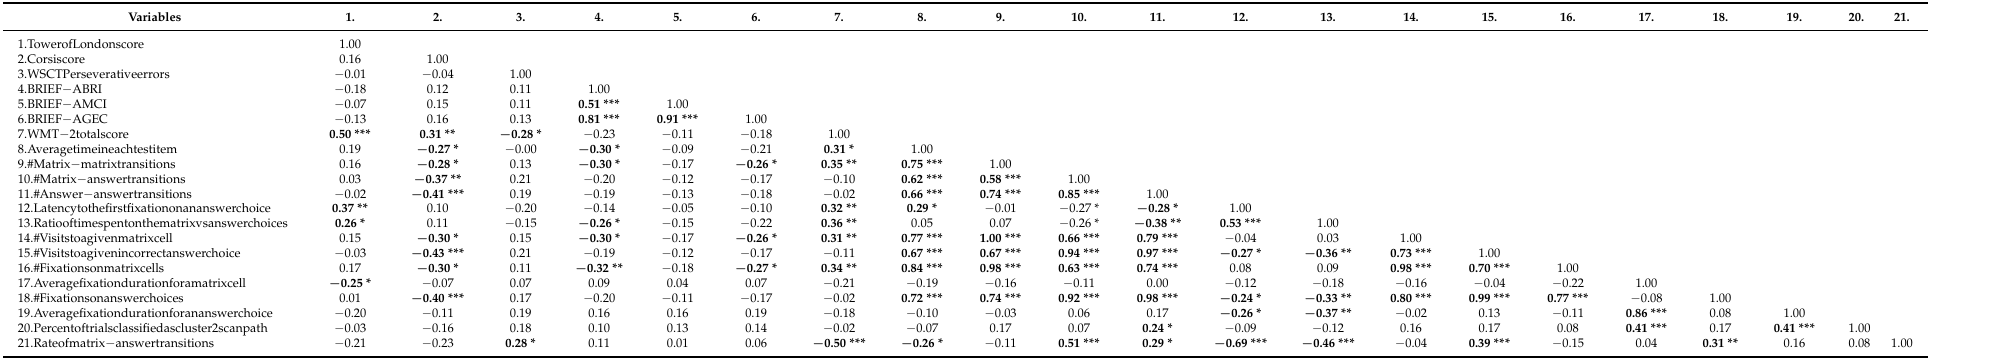
Table 5. Correlation matrix of the cognitive measures and eye-tracking metrics in Study